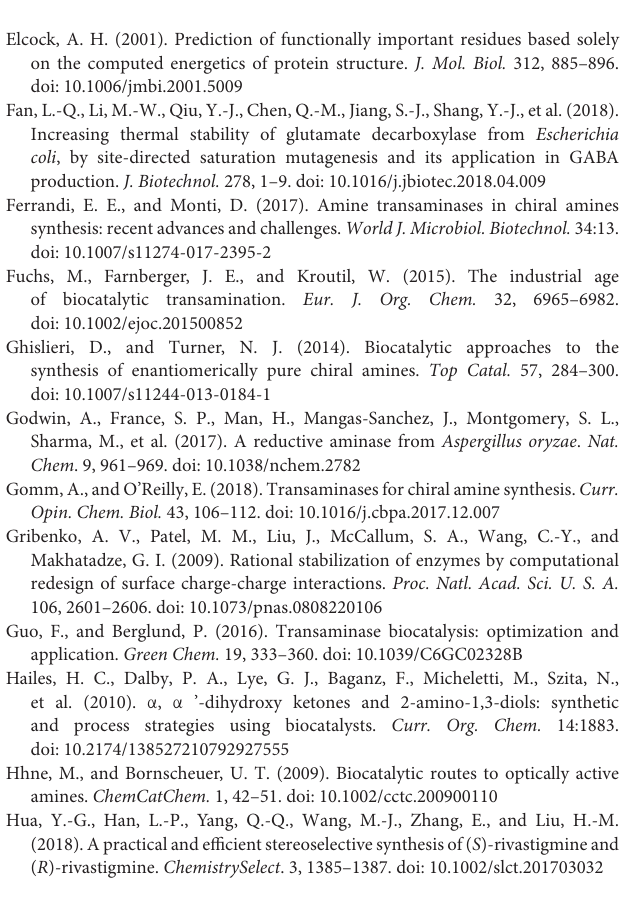
interactions were visualized in the crystal structure of At -ATA (PDB ID: 4CE5) using the program PyMOL (http://pymol.org). Supplementary Figure 2 | The SDS-PAGE analysis of wild-type and At -ATA mutants. Lanes: 1, Protein marker; 2, Wild-type; 3, E133A; 4, D224A; 5, E253A; 6, E262A. Supplementary Figure 3 | Thermal unfolding of wild-type At -ATA and its mutants were monitored by DSF. Supplementary Figure 4 | MD analysis of At -ATA and E133Q and E253A using YASARA at 313K in the last 20 ns. (A) The RMSF values of At -ATA and its mutants. (B) The detail RMSF values of α -helix 8 and α -helix. (C–F) The hydrogen bond interaction in two α -helix for the mutant E133Q; (G,H) the hydrogen bond interaction in two α -helix for the mutant E253A; The added bonds were displayed by red, and the blue one showed a shortened change compared with the wild type. Supplementary Table 1 | Primers used for site-directed mutagenesis. Supplementary Table 2 | The stability of the wild-type and stabilized mutant At